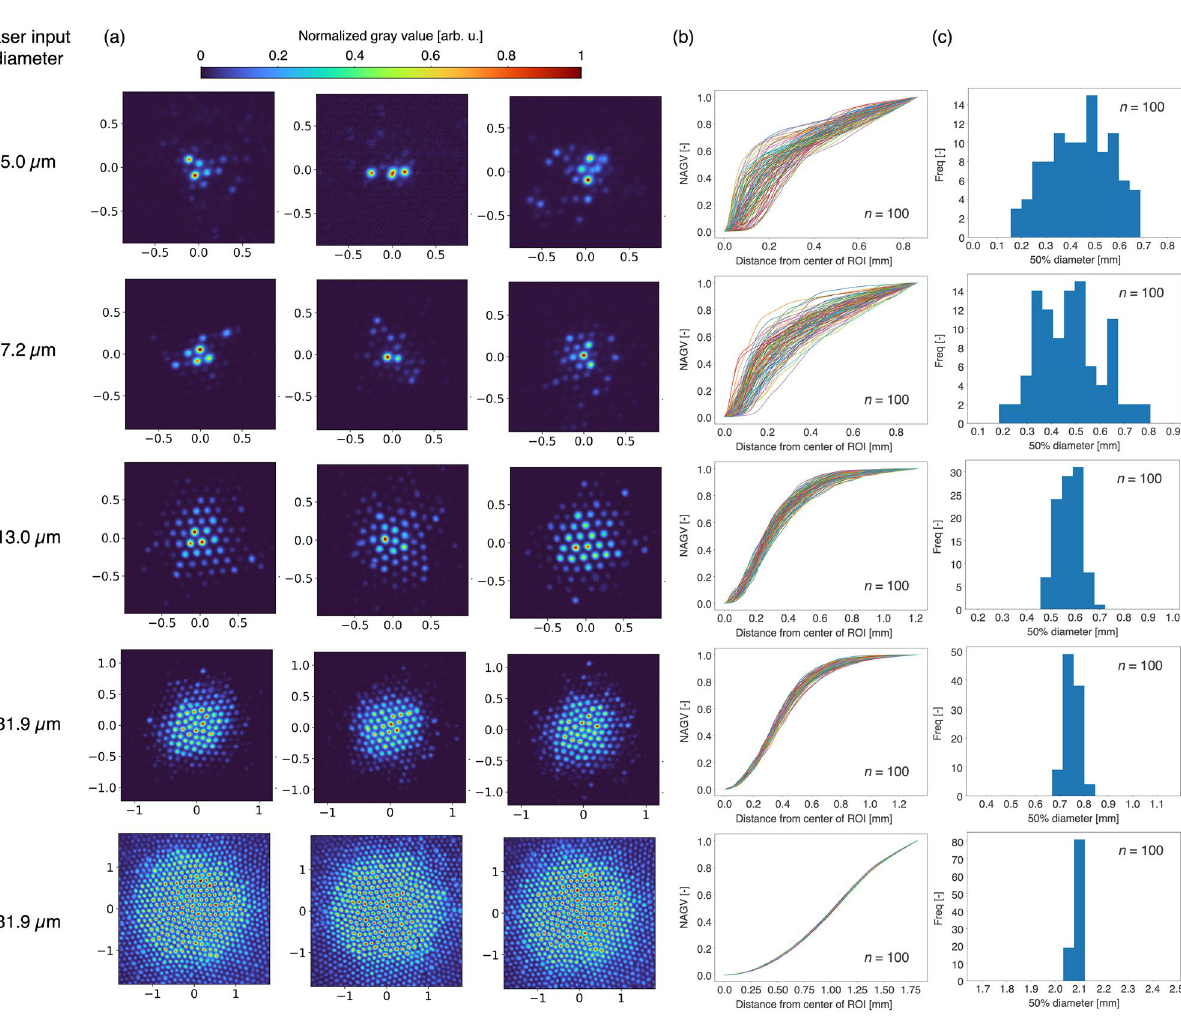
Figure 5. ( a ) Light intensity distribution examples on the distal irradiated plane for the input laser diameters of 5.0, 7.2, 13.0, 31.9, and 81.9 µ m. All images were normalized by the maximum gray value in each image (unit: mm). ( b ) NAGV at various distances from the center of ROI. ( c ) Histograms of the diameter of the circle including 50 % of the total gray value in the region of